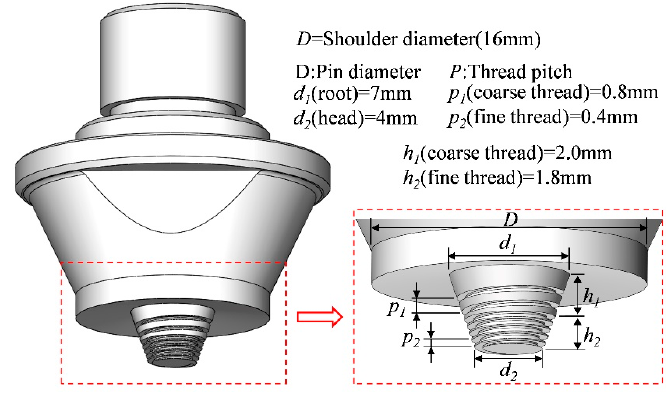
Figure 2. Schematic of the tool with a variable-pitch thread pin.